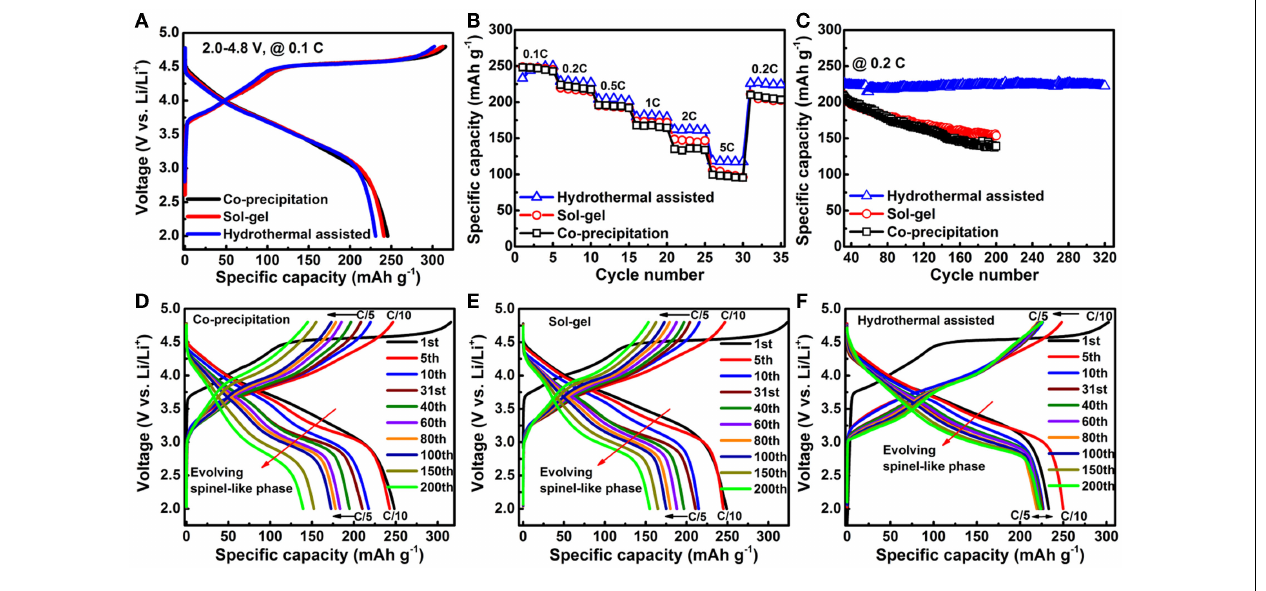
charge/discharge profile evolutions of materials prepared by the (D) CP; (E) SG; and (F) HA methods during long-term cycling (Zheng et al., 2014a). Reprinted with permission from Zheng et al. (2014a). Copyright 2014 American Chemical Society.